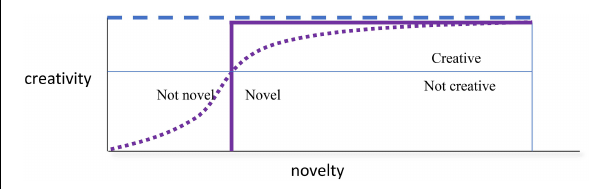
FIGURE 3 | Hypothetical creativity assessment as a function of novelty. Thick solid purple line indicates simple threshold approach to assessing creativity. If novelty exceeds the threshold, the novelty criterion is satisfied. The monotonic increasing function is illustrated by the dotted curve. The functions are adjusted in this illustration such that they produce an assessment of “creative” (i.e., above the thin blue horizontal line) at the same threshold level of novelty. The dashed line is a reminder that the “usefulness” criterion has been met for all levels of novelty